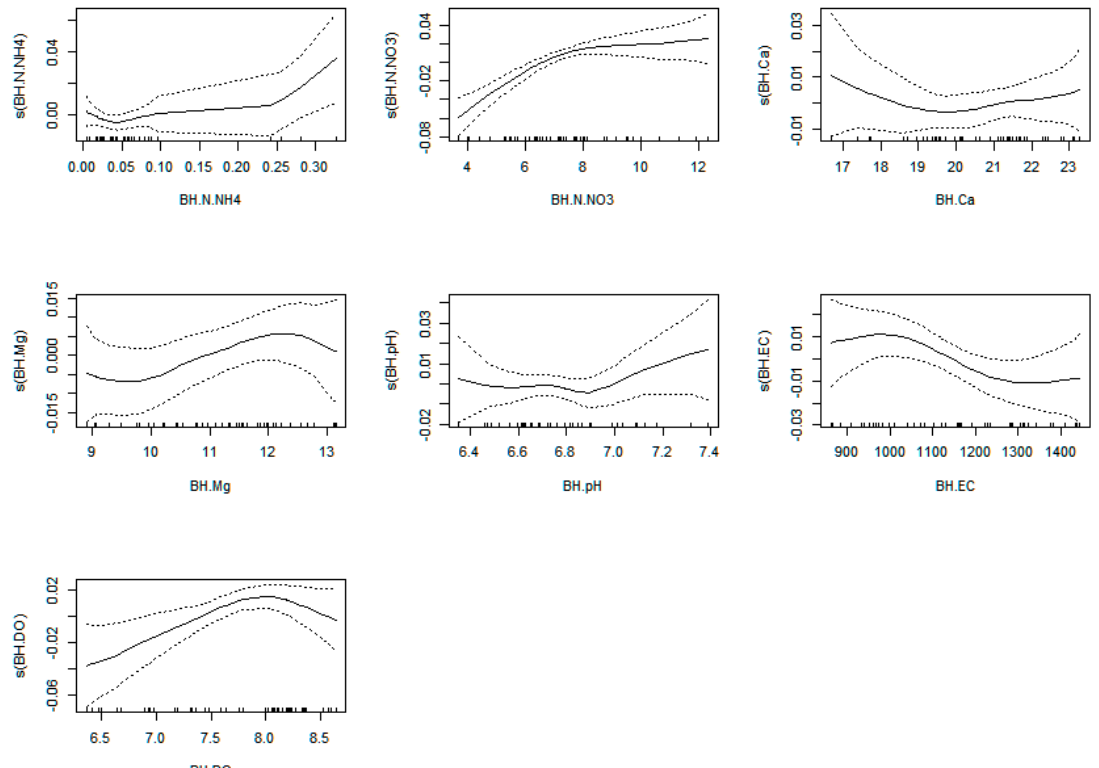
Figure A24. The GAM predictors influence over N-NO 2 for BH experimental variant.